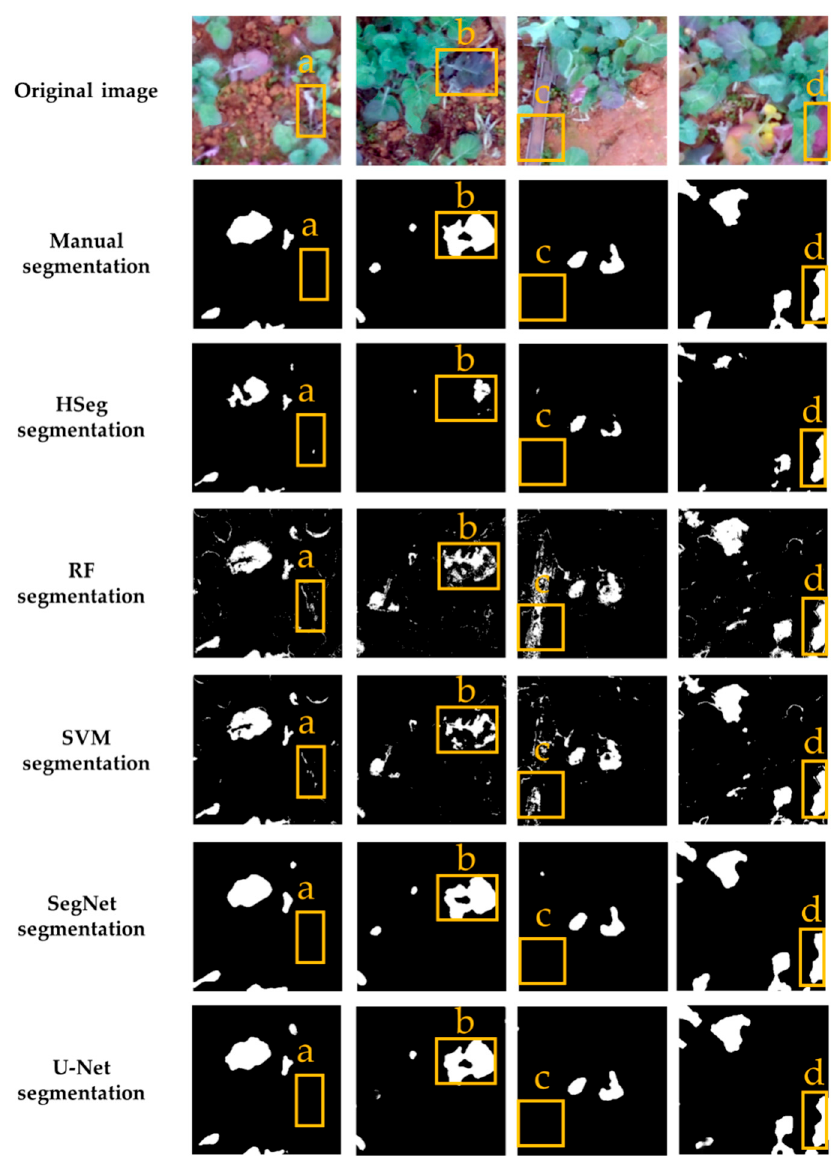
Figure 6. Purple rapeseed leaf extraction results obtained using five methods. Four representative rapeseed field images were selected to illustrate the segmentation effects. The first row shows the original rapeseed images in the field. The second row shows the manual segmentation results obtained using ArcMap software. The third to seventh rows show the purple rapeseed leaf segmentation results obtained using HSeg, random forest (RF), support vector machine (SVM), SegNet, and U-Net, respectively. Objects of interest (a withered leaf in region a, a darker purple leaf in region b, a ground object in region c, and a purple leaf overlapping with a green leaf in region d) were marked with orange boxes.